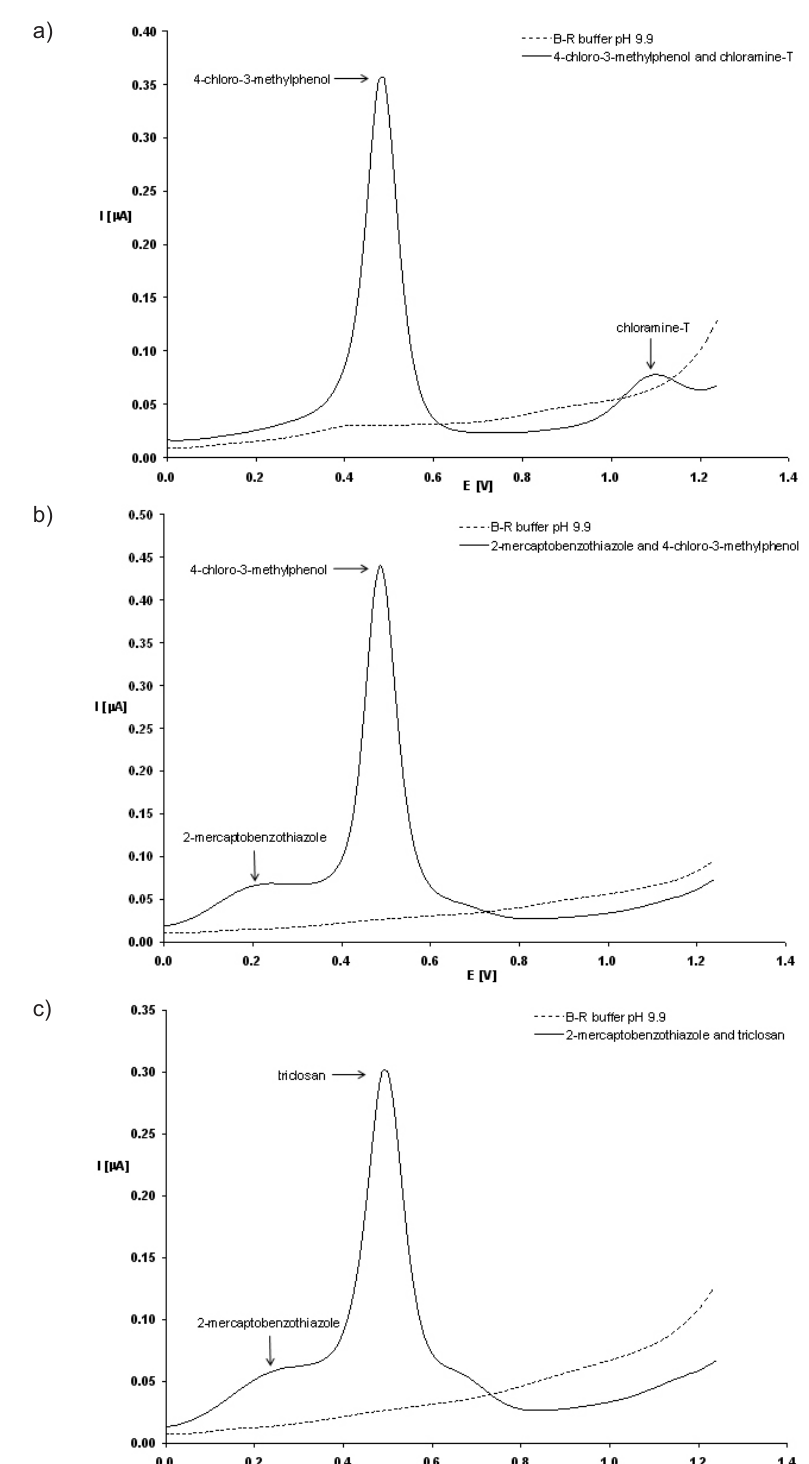
Figure 3. Differential pulse voltammograms of mixtures of disinfectants in Britton-Robinson buffer of pH 9.9: a) 4-chloro-3-methylphenol (210.4 µM) and chloramine-T (131.8 µM), b) 2-mercaptobenzothiazole (179.4 µM) and 4-chloro-3-methylphenol (210.4 µM), c) 2-mercaptobenzothiazole (179.4 µM) and triclosan (103.6 µM). Scan rate: 50 mV s -1